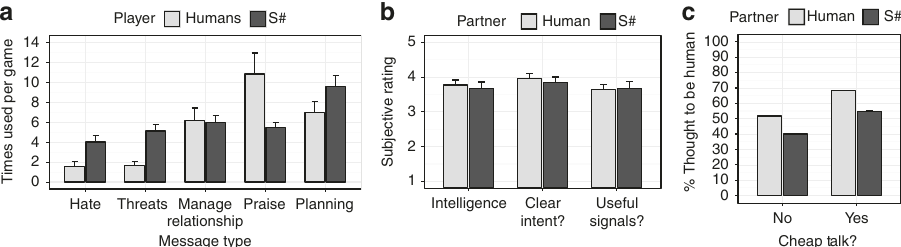
Fig. 5 Explanatory results from the culminating user study. a The speech pro fi les of participants and S#, which shows the average number of times that people and S# used messages of each type (see Supplementary Note 7 for message classi fi cation) over the course of an interaction when paired with people across all games. Statistical tests con fi rm that S# sent signi fi cantly more Hate and Threat messages, while people sent more praise messages. b Results of three post-experiment questions for subjects that experienced the condition in which cheap talk was permitted. Participants rated the intelligence of their partner (Intelligence), the clarity of their partner ’ s intentions (Clear intent?), and the usefulness of the communication between them and their partner (Useful signals?). Answers were given on a 5-point Likert scale. Statistical analysis did not detect any signi fi cant differences in the way users rated S# and human partners. c The percentage of time that human participants and S# were thought to be human by their partner. Statistical analysis did not detect any difference in the rates at which S# and humans were judged to be human. Further details along with the statistical analysis for each of these results are provided in Supplementary Note